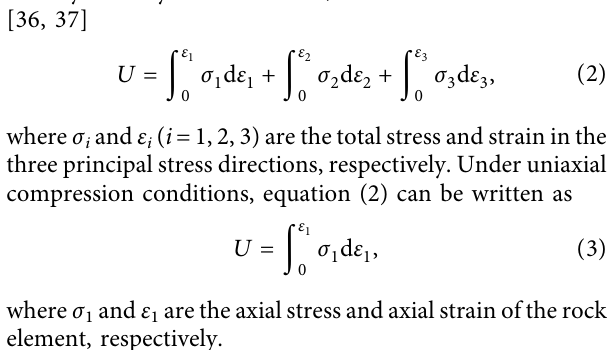
Figure 4: Relationship between dissipated energy and elastic energy.